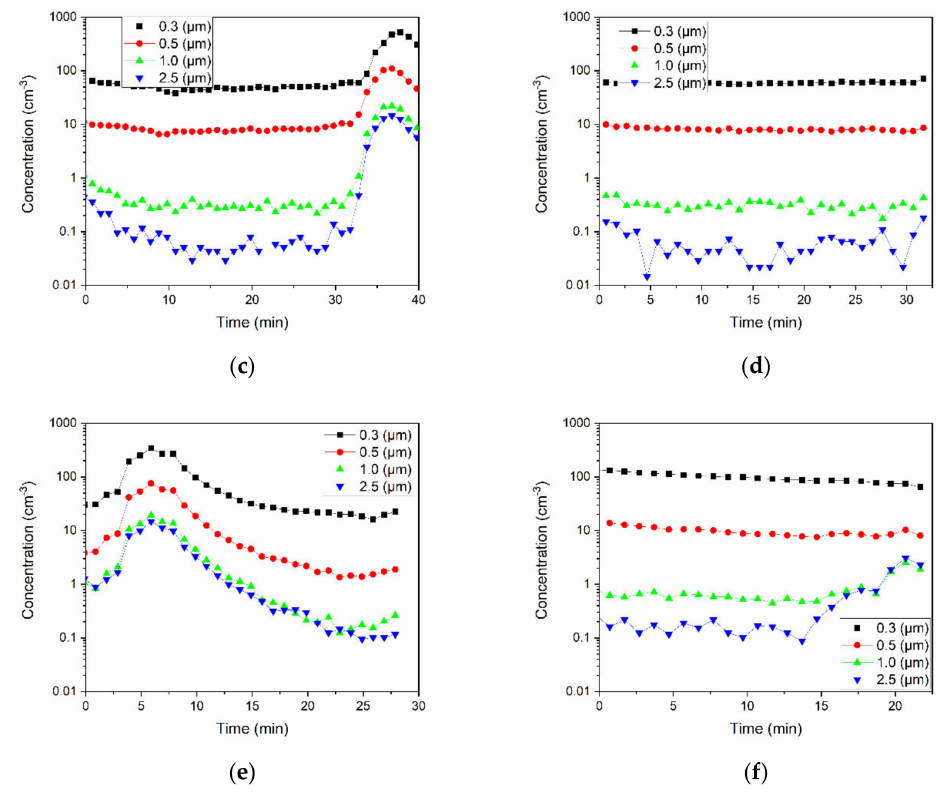
Figure 7. Number concentrations of sub-0.5-, 0.5-, 1-, and 2.5- µ m particles measured in the corner of the office for ( a – d ) closed-door cases with ( a ) air purifier off, ( b ) low-speed air purifier turned on after particle generation, ( c ) high-speed air purifier turned on after particle generation, and ( d ) high-speed air purifier running from the beginning of particle generation; and ( e , f ) open-door cases with ( e ) air purifier off and ( f ) high-speed air purifier running from the beginning of particle